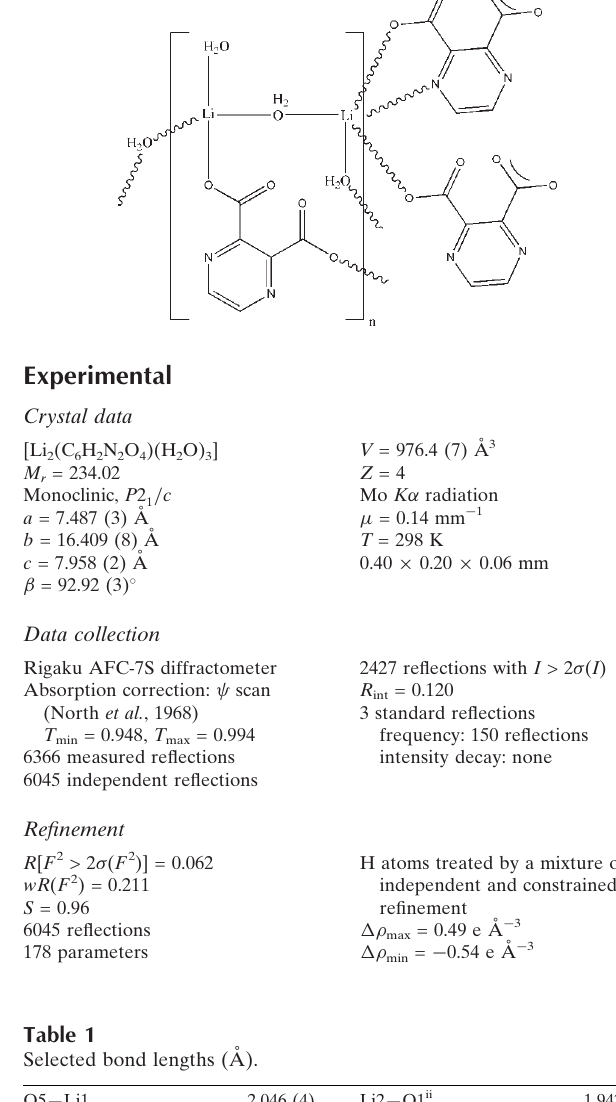
Experimental Crystal data